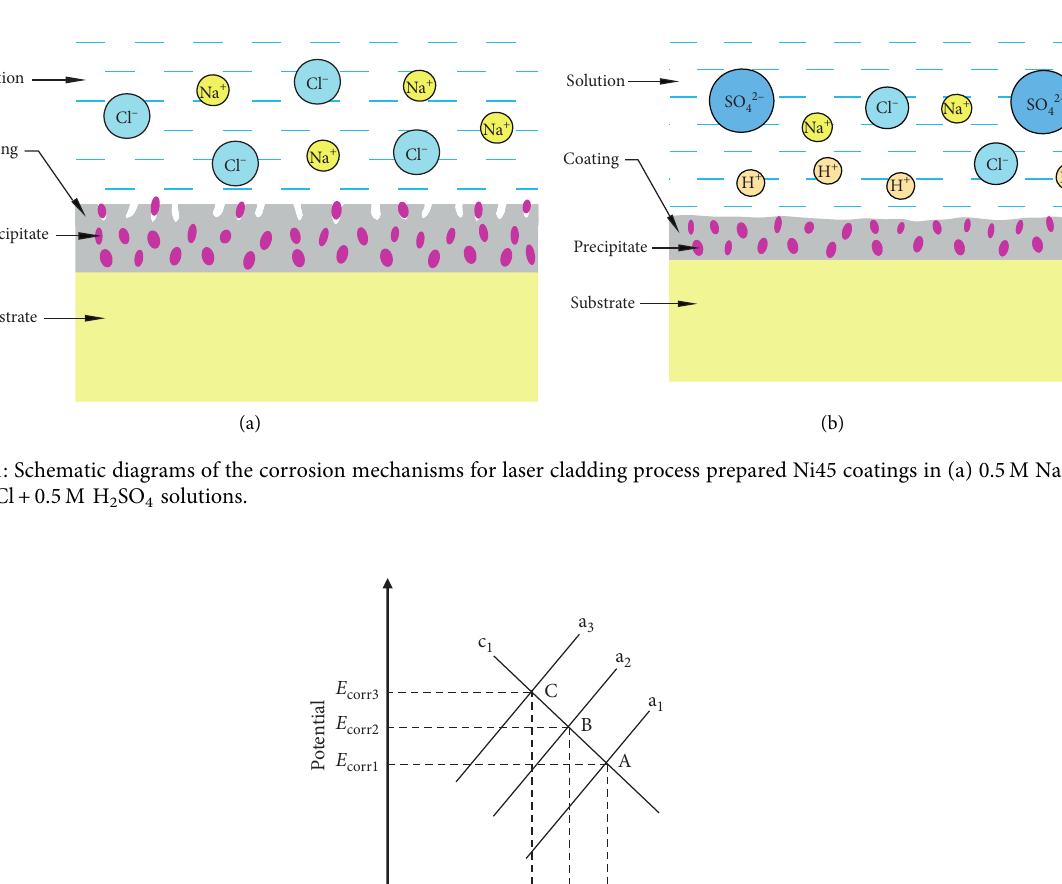
2 SO 4 solutions.